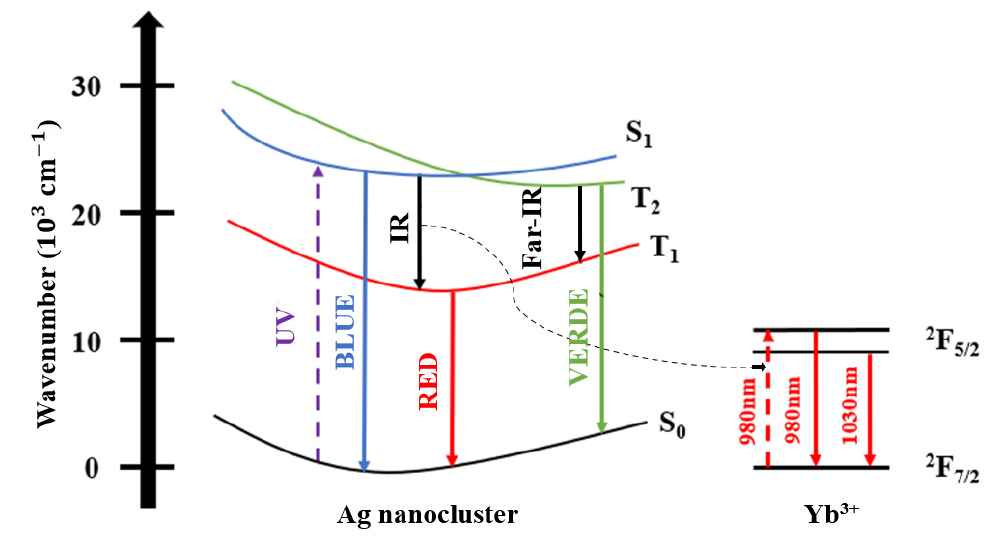
Figure 5. Simplified Ag NCs energy diagram with ET to Yb 3+ ions.